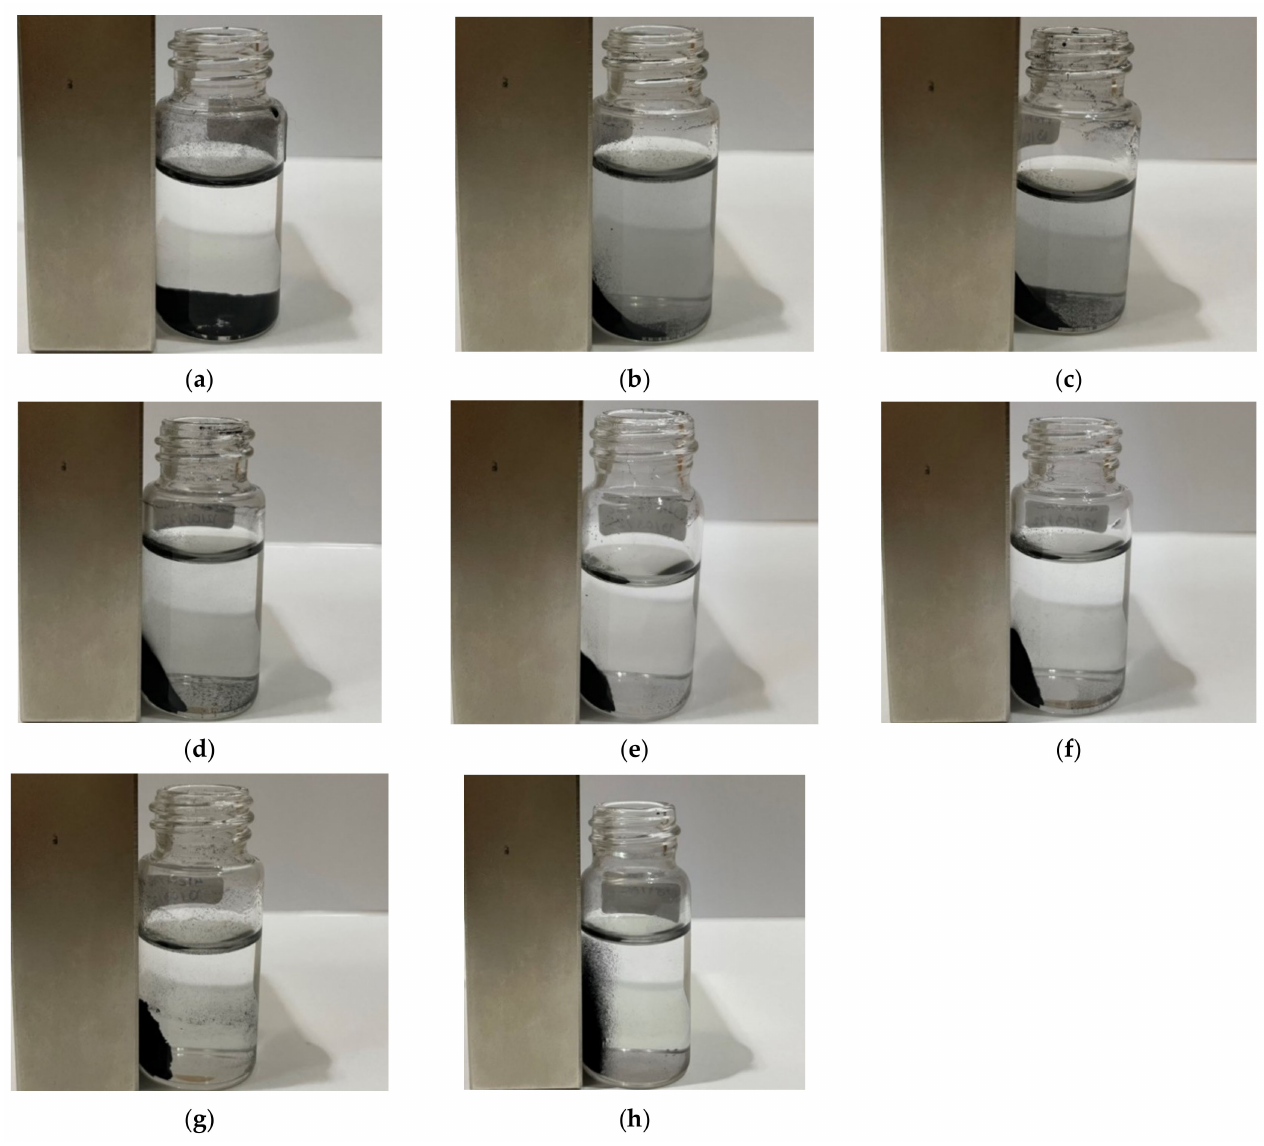
Figure 4. Magnetic separation of ( a ) 0.15FePt /AC, ( b ) 0.5FePt/AC, ( c ) 1FePt/AC, ( d )